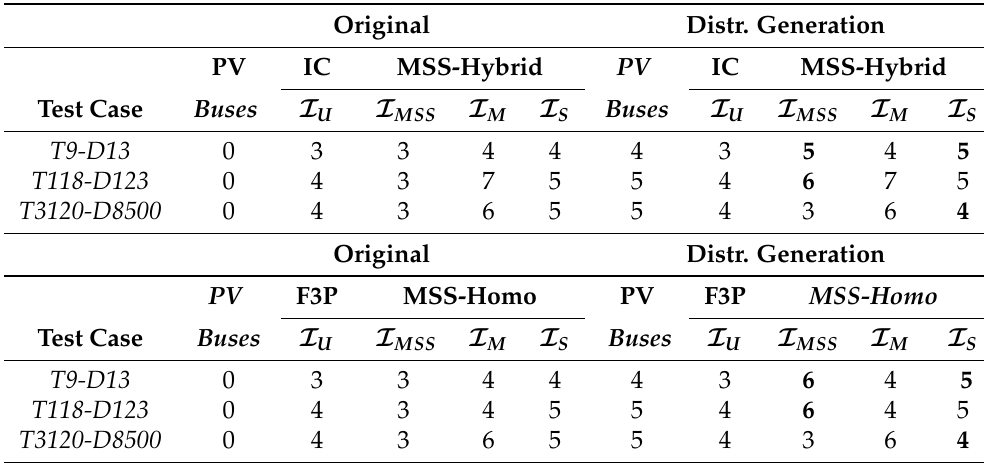
Table 8. Influence of PV buses on the number of iterations. The changes in iteration number compared to the original network are